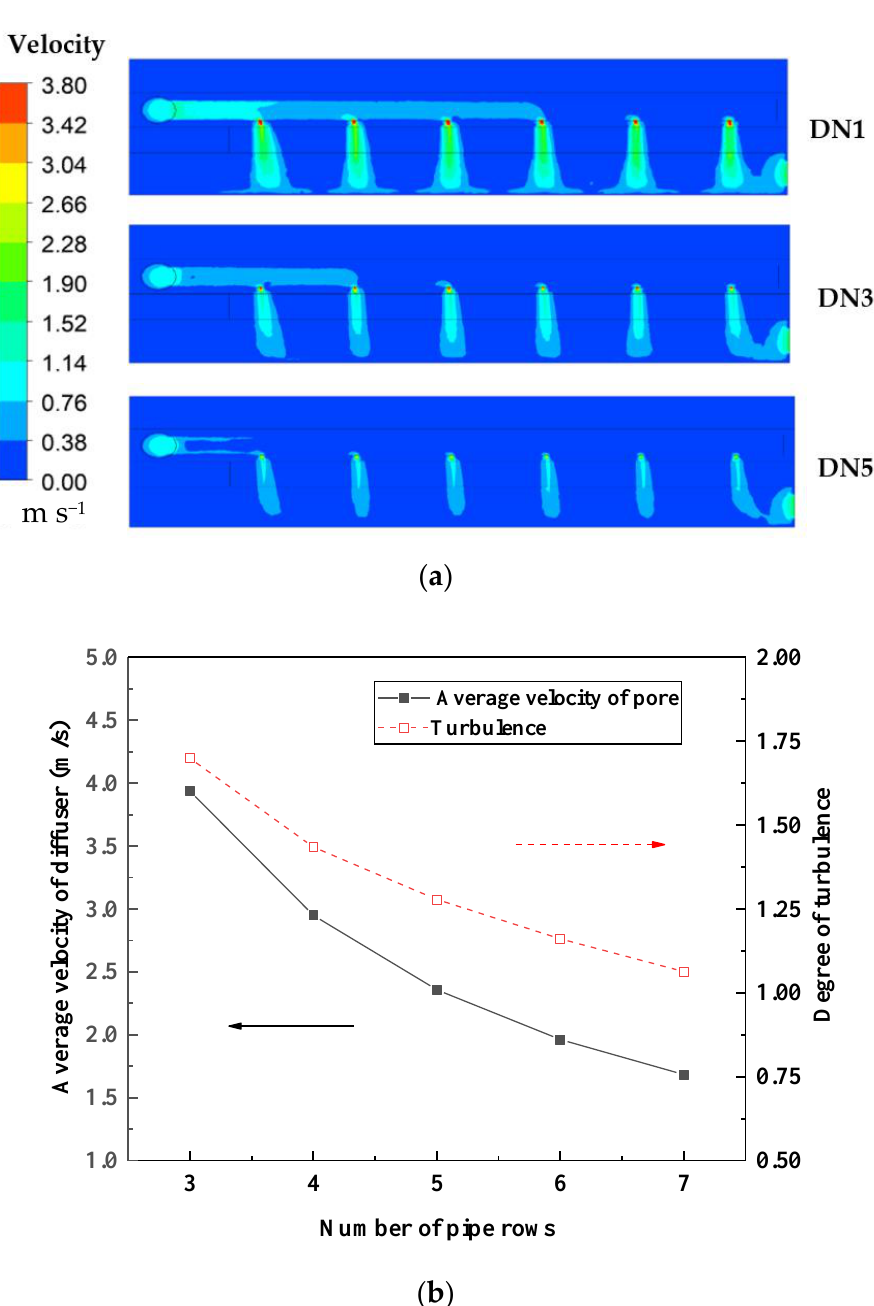
Figure 2. ( a ) Distribution of the velocity at the middle x–y plane of the branch pipe with a typical number of three trunk pipe rows and ( b ) average velocity and degree of the turbulence for the water diffuser under different numbers of trunk pipe rows.